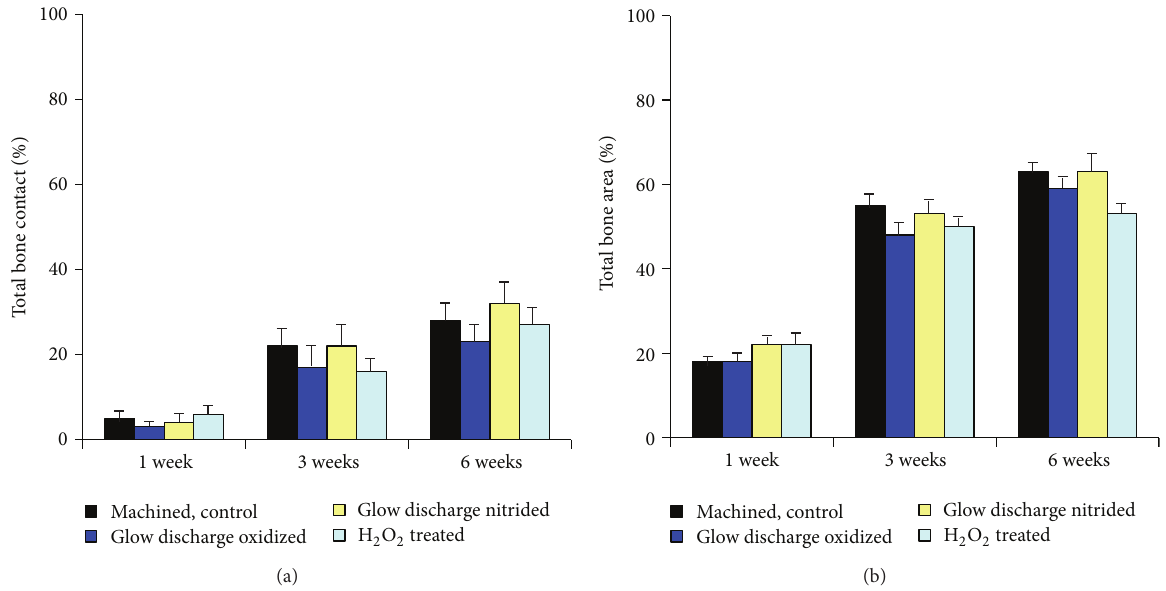
Figure 3: Morphometry. (a) Total bone contact (%) after 1, 3, and 6 weeks. Mean + s. e. (b) Total bone area (%) after 1, 3, and 6 weeks. Mean + s. e.